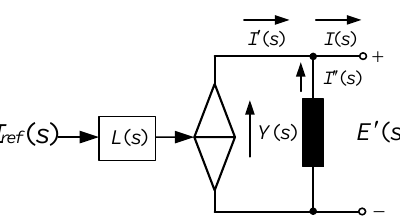
Figure 5. Current-loop model- admittance form of a single-inverter system.